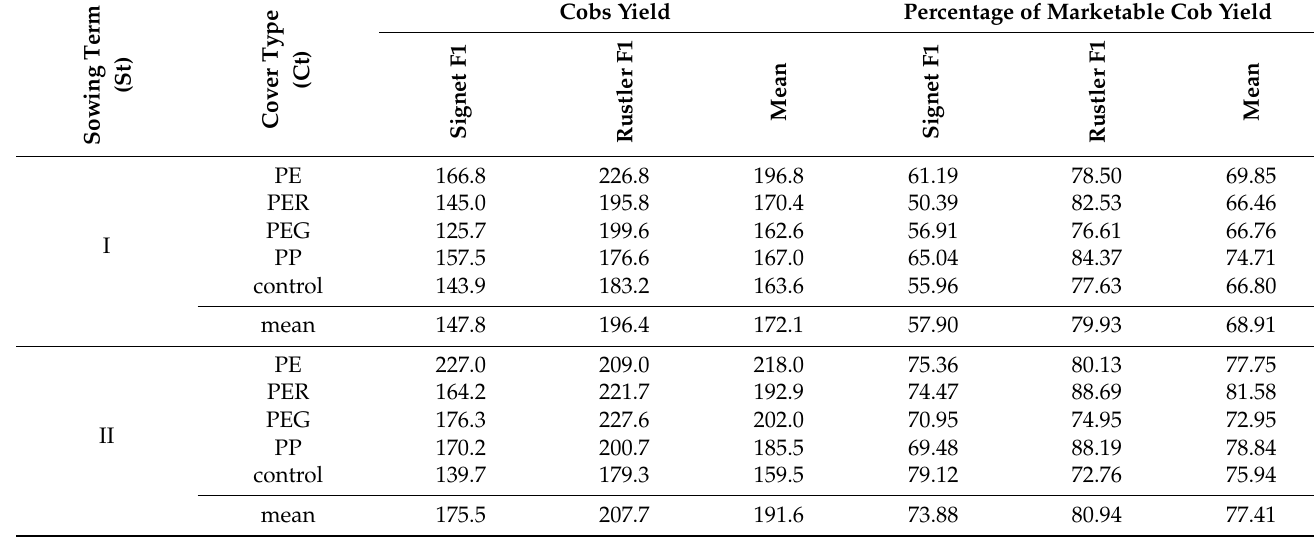
Table 3. Total cobs yield (dt per ha) and percentage (%) of marketable cobs yield. Average from years 2012–2014.